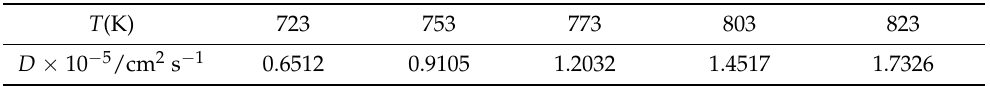
Figure 4. ( a ) Relationship between the peak cathode current and the square root of the scan rate in the cyclic voltammetry of 3LiCl-2KCl-CeCl 3 across different temperatures at the liquid metal indium electrode in LiCl-KCl melts. Scanning speed: 0.05–0.2 V-s − 1 , ( b ) Diffusion coefficient of Ce 3+ on liquid metal indium electrode versus temperature in LiCl-KCl melt at different temperatures. Table 2. Diffusion coefficients of Ce 3+ ions in LiCl-KCl melt at different temperatures at liquid metal indium